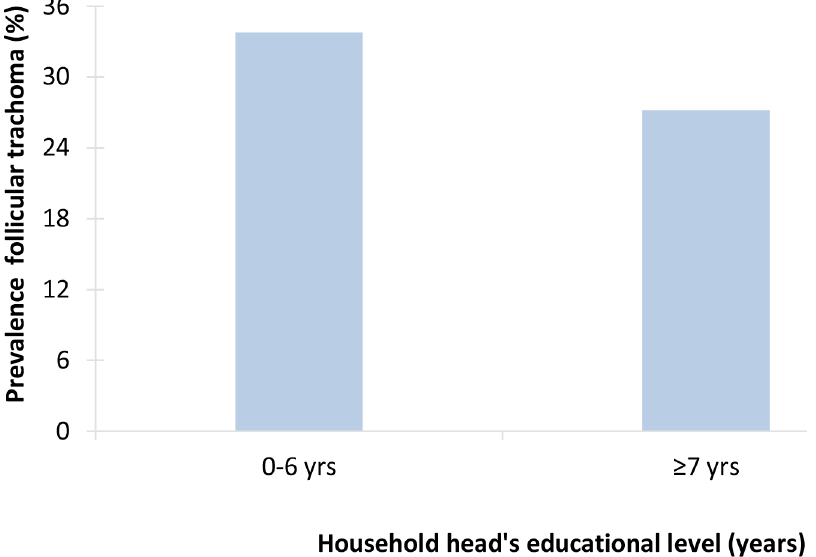
Fig 10. Example of socioeconomic inequalities in trachoma: association between educational attainment of household head and follicular trachoma in young children in Tanzania (2008) [79]. The study was conducted among children aged 0 – 5 years in 36 communities (3,122 children) in 2008. The eyes of the children were examined for active trachoma, and information on the educational attainment of the household head was collected through a questionnaire. The prevalence of follicular trachoma was 30.9%. Lower educational attainment of the household head was associated with a higher risk of follicular trachoma among children in both countries (Tanzania p =